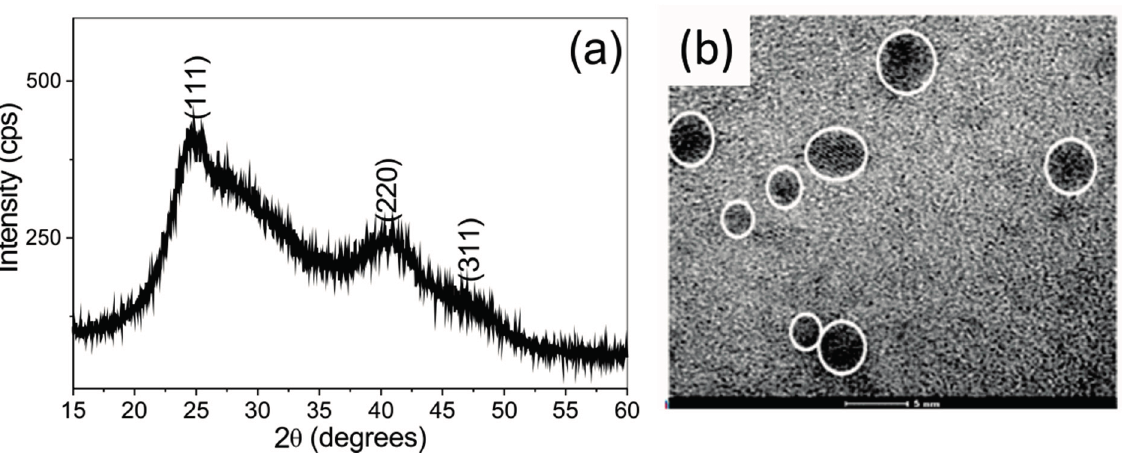
Figure 2. Structural characterization of the CdTe QDs used here. ( a ) A representative X-ray powder diffratogram of CdTe-MSA dried nanocrystals; ( b ) Transmission electron microscopy of CdTe-MSA. The circled electron dense structures represent individual nanoparticles. Bar = 5